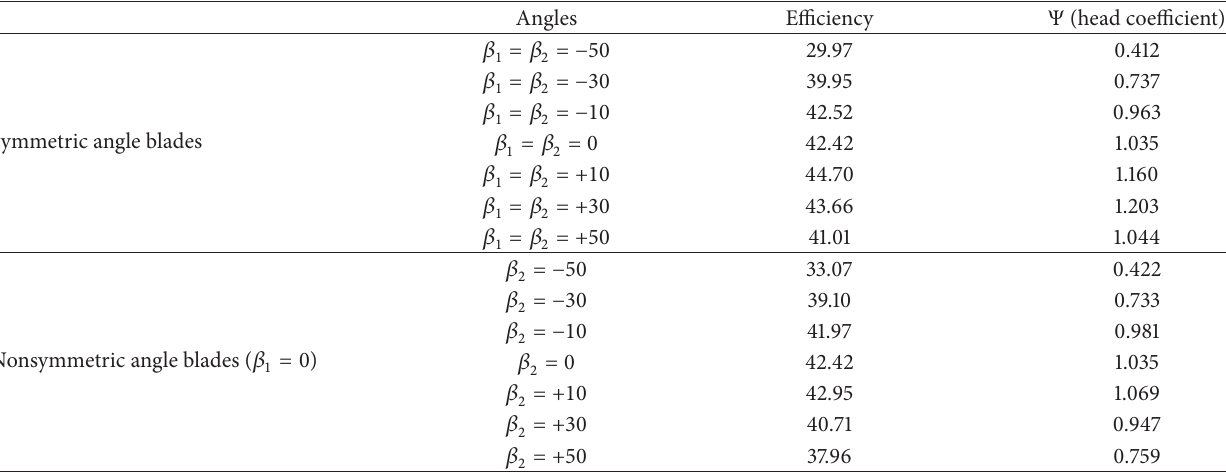
Figure 16: Characteristics curves of the regenerative pump: (a) symmetric blades and (b) nonsymmetric blades. Table 5: Results of numerical study at design flow